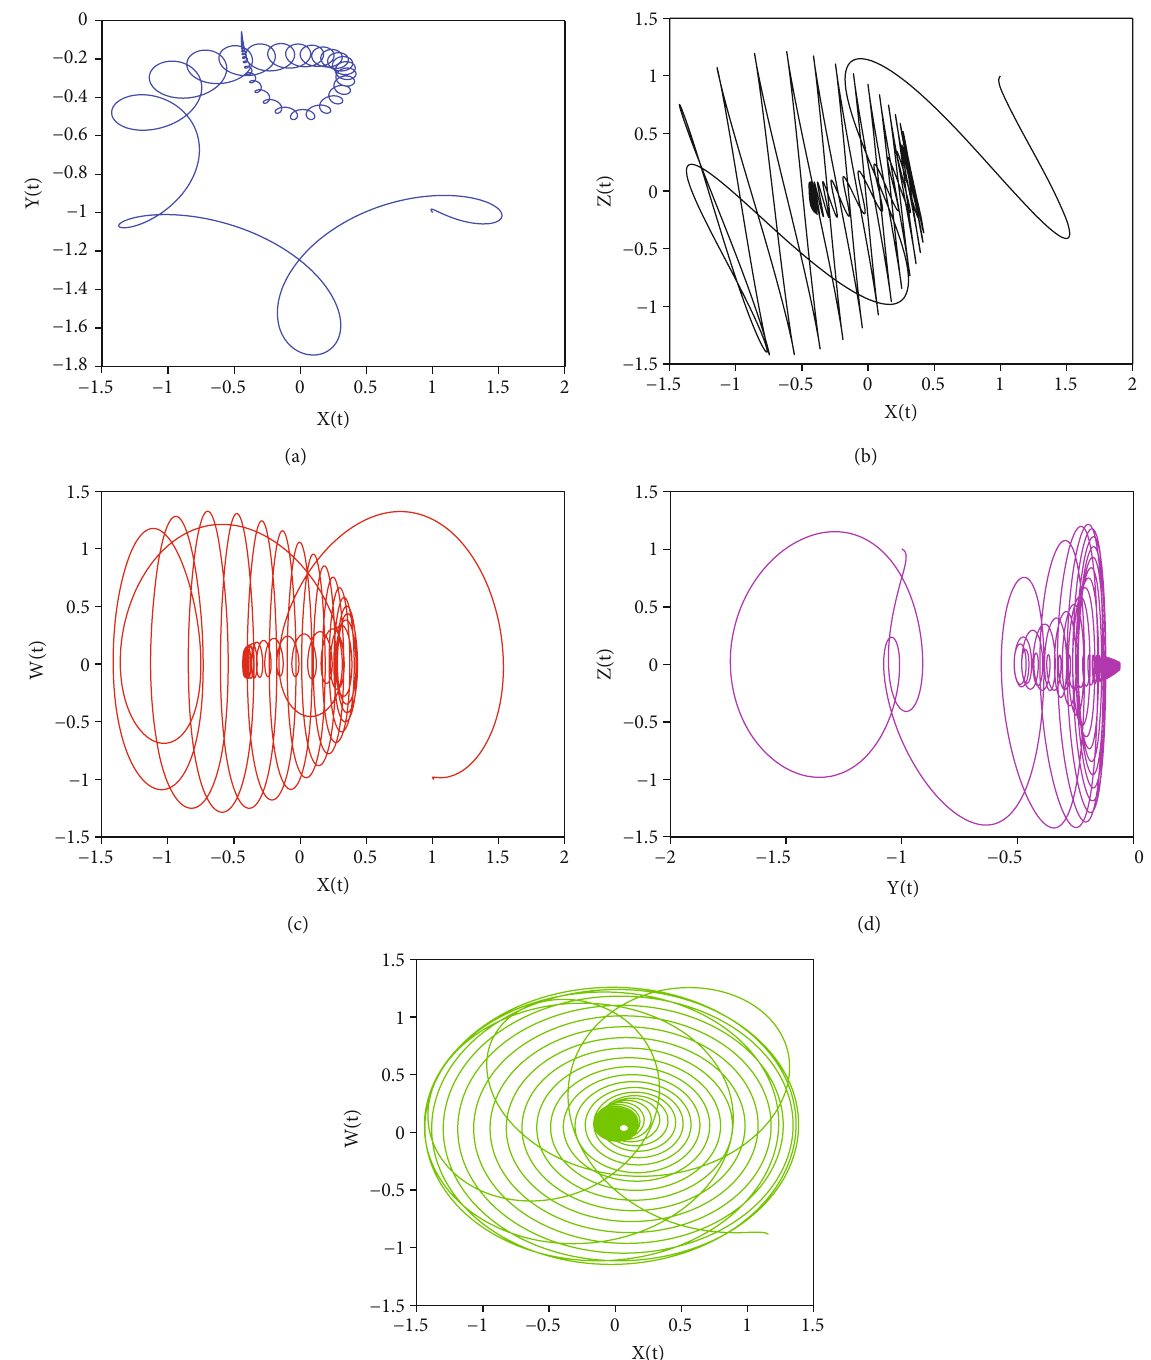
Figure 11: The behavior of di ff erent state variables of system 2 with fractional order ϖ = 0 : 99 and the parameters are considered as m = n = 5